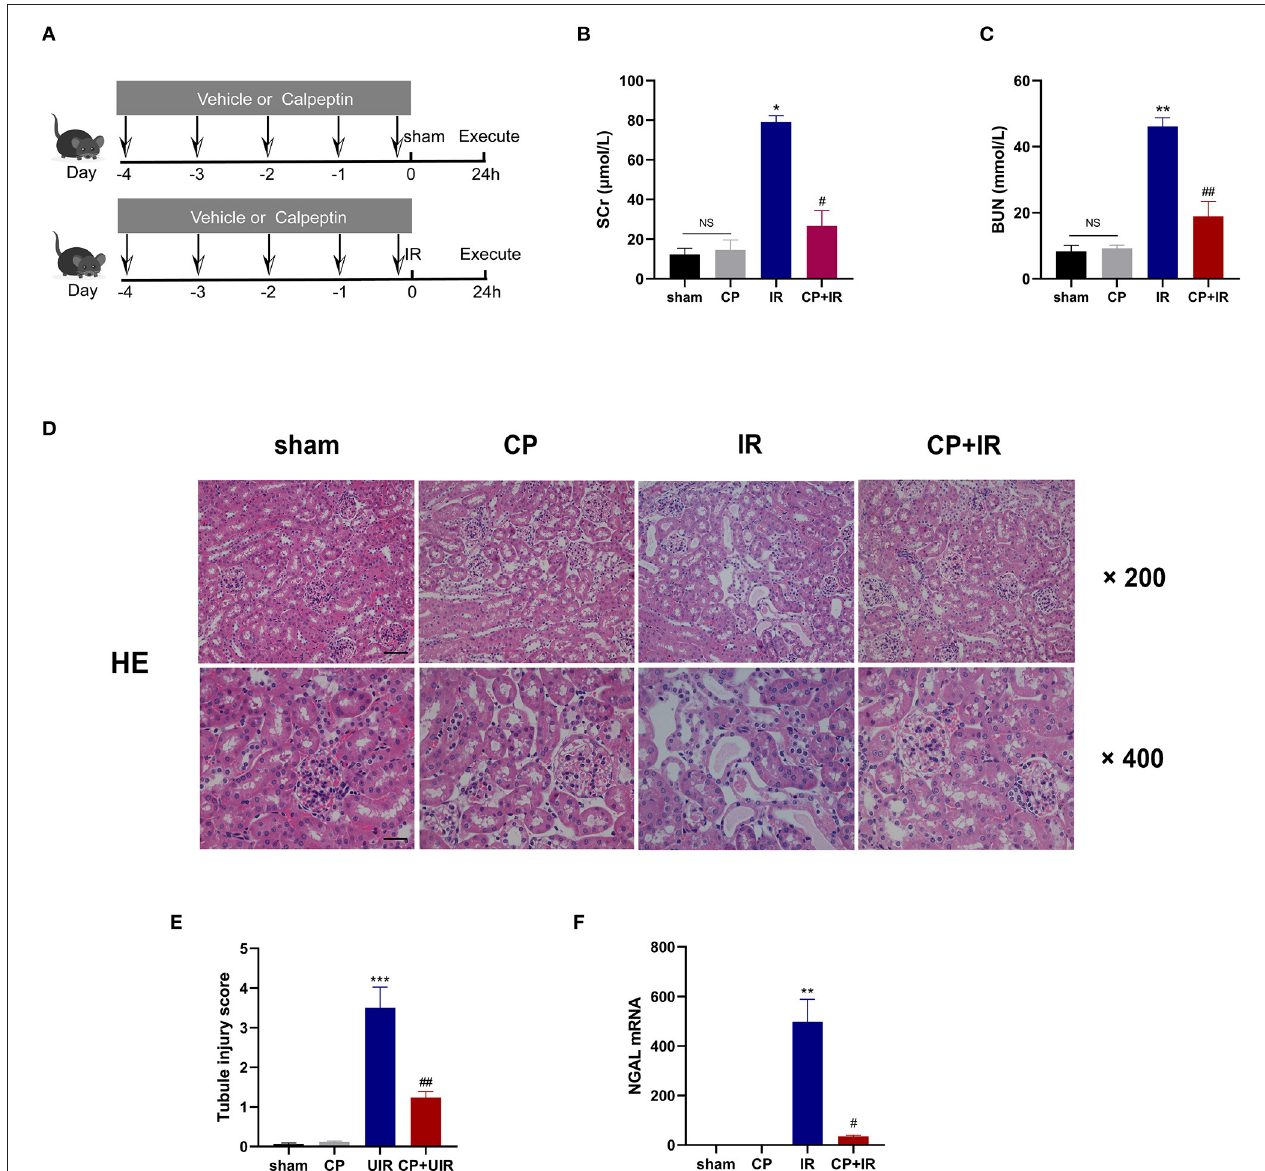
FIGURE 2 | Calpeptin significantly ameliorates renal dysfunction and renal tubule injury in IR mouse model. (A) The schematic diagram of animal experiments was displayed and all mice were divided into 4 groups: (1) sham; (2) CP; (3) IR; (4) CP + IR. (B,C) The renal function was measured by serum creatine and blood urea nitrogen. (D) The renal pathological changes were assessed by H&E staining. × 200, bar = 100 µ m; × 400, bar = 50 µ m. (E) Quantitative analysis of tubule injury score. (F) The renal damages of all groups were evaluated by the NGAL mRNA levels. All values were presented as mean ± SEM ( n = 3). NS, no significance; * p